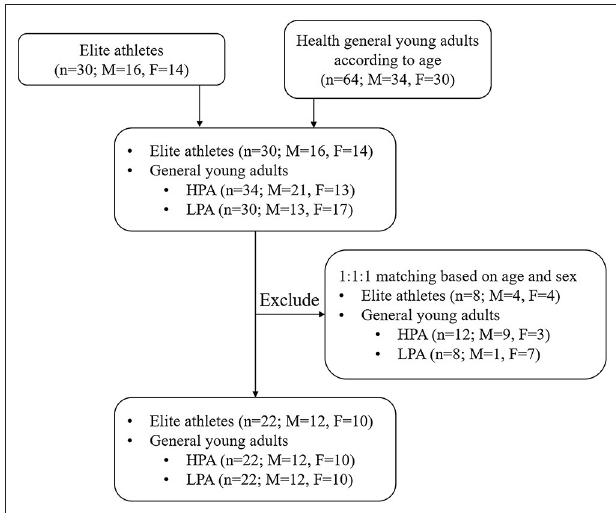
FIGURE 1 | Schematic presentation of the flow of participants through